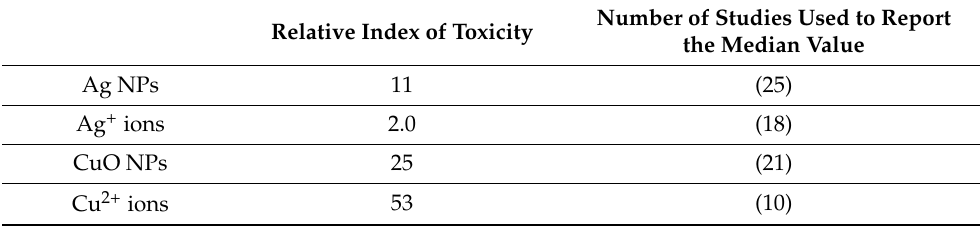
Table 1. Mammalian cells in vitro relative cytotoxicity